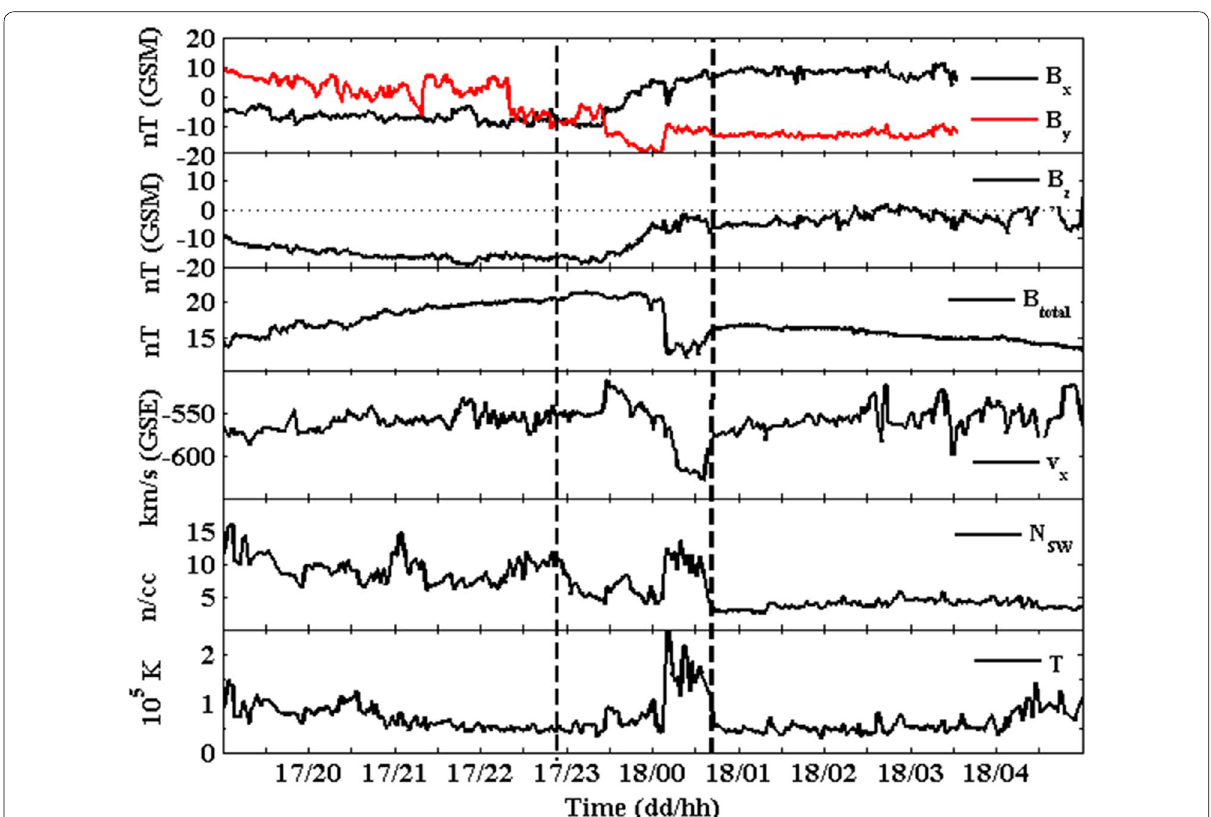
Fig. 2 From top to bottom: components of IMF viz B x , B y and B z , B total , x-component of solar wind velocity ( v x ), solar wind density ( N sw ), temperature variation of electron flux along the IMF direction (T), as observed by WIND spacecraft during 19:00–05:00 UT on 17–18 March 2015. Components of interplanetary magnetic field are plotted in GSM coordinates and the x-component of solar wind velocity is plotted in GSE coordinates. The expansion phase of the substorm, 17–18 March 2015, during 22:58—00:41 UT on 17–18 March 2015 is marked with two vertical